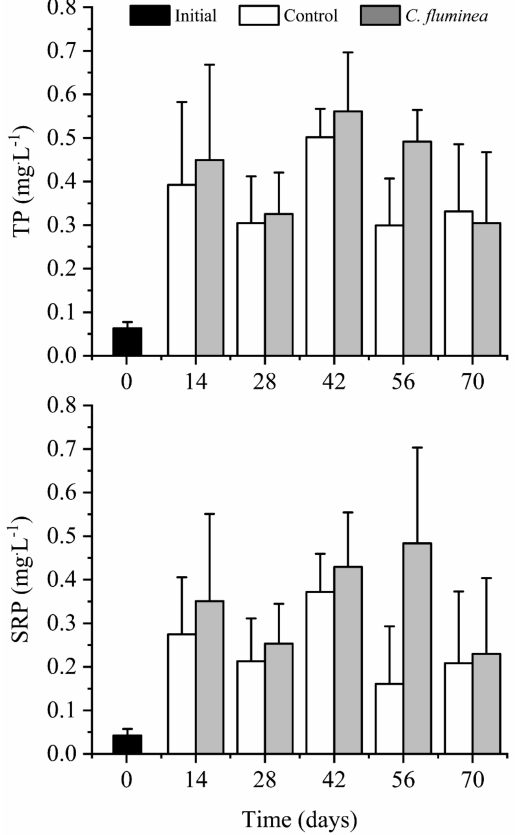
Figure 2. Total phosphorus (TP, mean ± SD) and soluble reactive phosphorus (SRP, mean ± SD) in different treatments over time. There is no significant difference between treatments at p < 0.05.